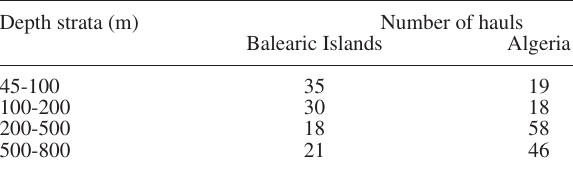
Table 1. – Number of hauls in each of the depth strata considered in the sampling design in both areas. Depth strata